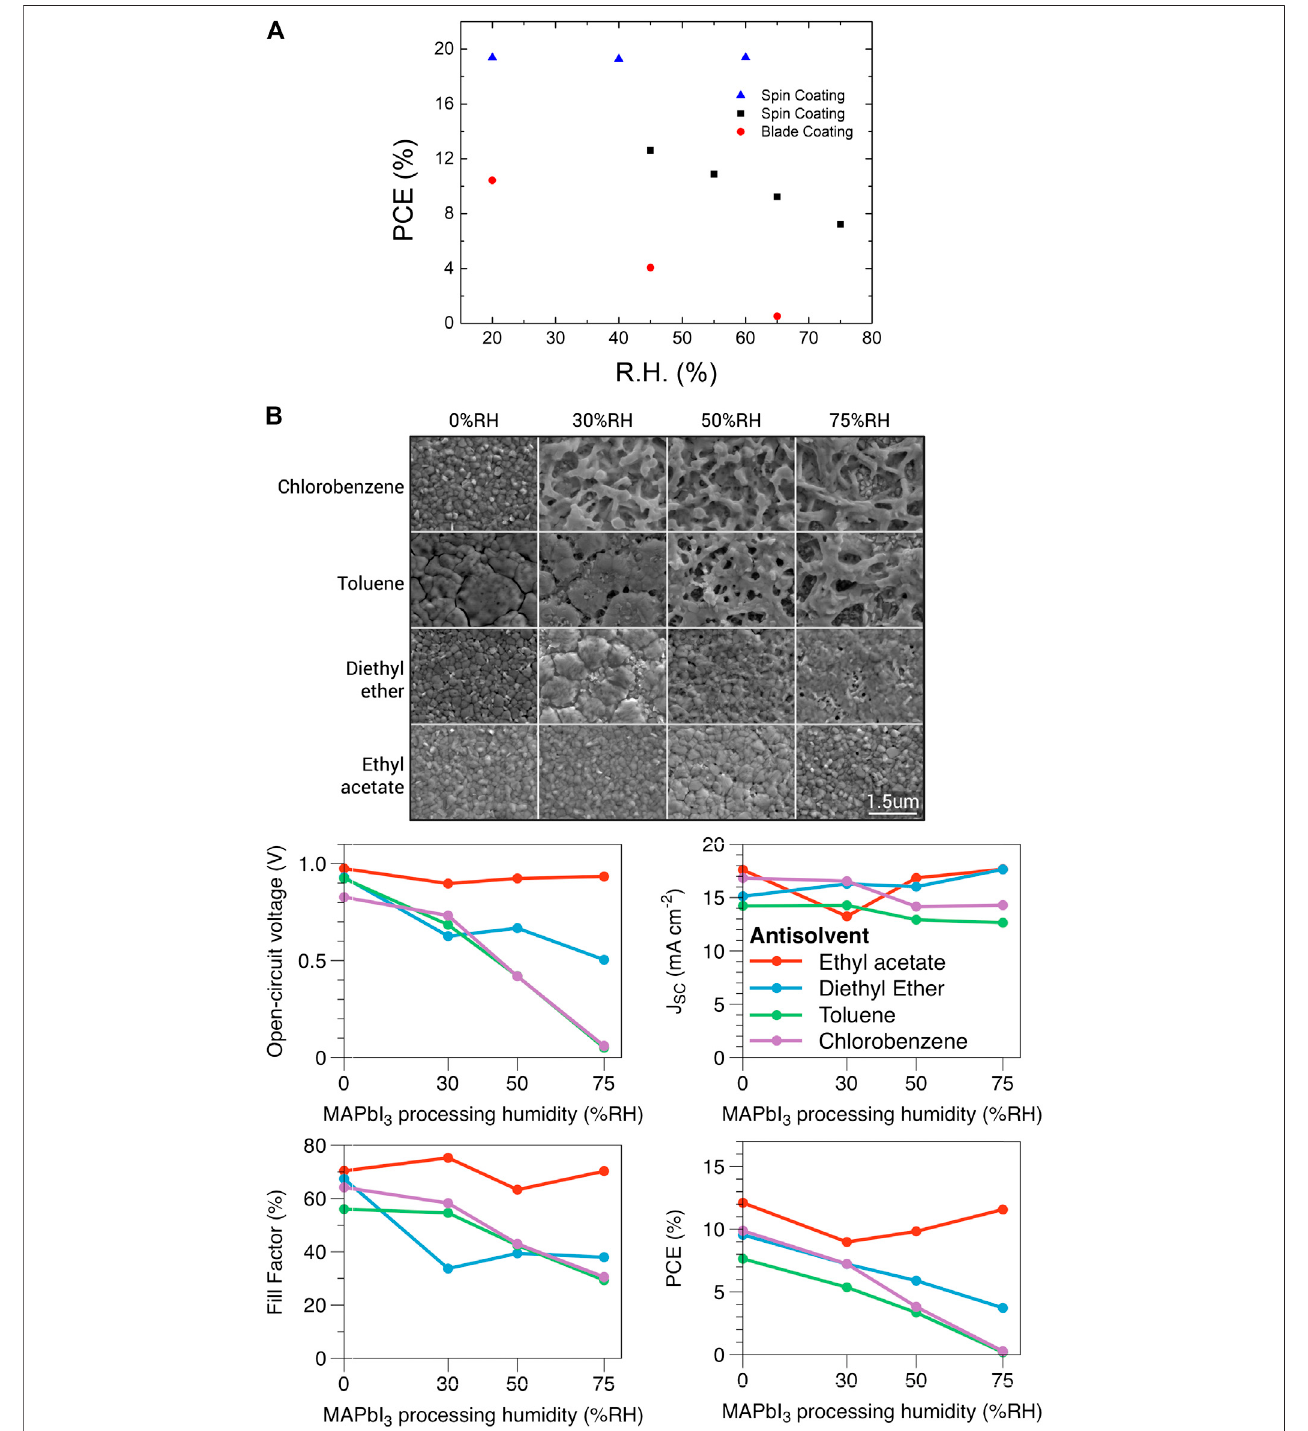
FIGURE 4 | (A) Photovoltaic performance of the perovskite thin fi lms fabricated in ambient conditions at different relative humidity levels. Data are extracted from (Liuetal.,2017)forthetwo-stepspin-coatingmethod(squares),(Yangetal.,2015)fortheblade-coatingmethod(circles),and(Chengetal.,2019)forthetwo-stepspin- coatingmethodwithanoptimizedmolarratioatspeci fi cRH(triangles). (B) SEMmicrographsoftheperovskite fi lmsfabricatedbythespin-coatingmethodatdifferentRH levelsanddifferentanti-solventsandthecorrespondingphotovoltaicdeviceparameters.AdaptedunderthetermsoftheCC-BYCreativeCommonsAttribution4.0 International License (http://creativecommons.org/licenses/BY/4.0/) (Troughton et al., 2017). Copyright 2017 The Authors. Published by Elsevier Ltd.